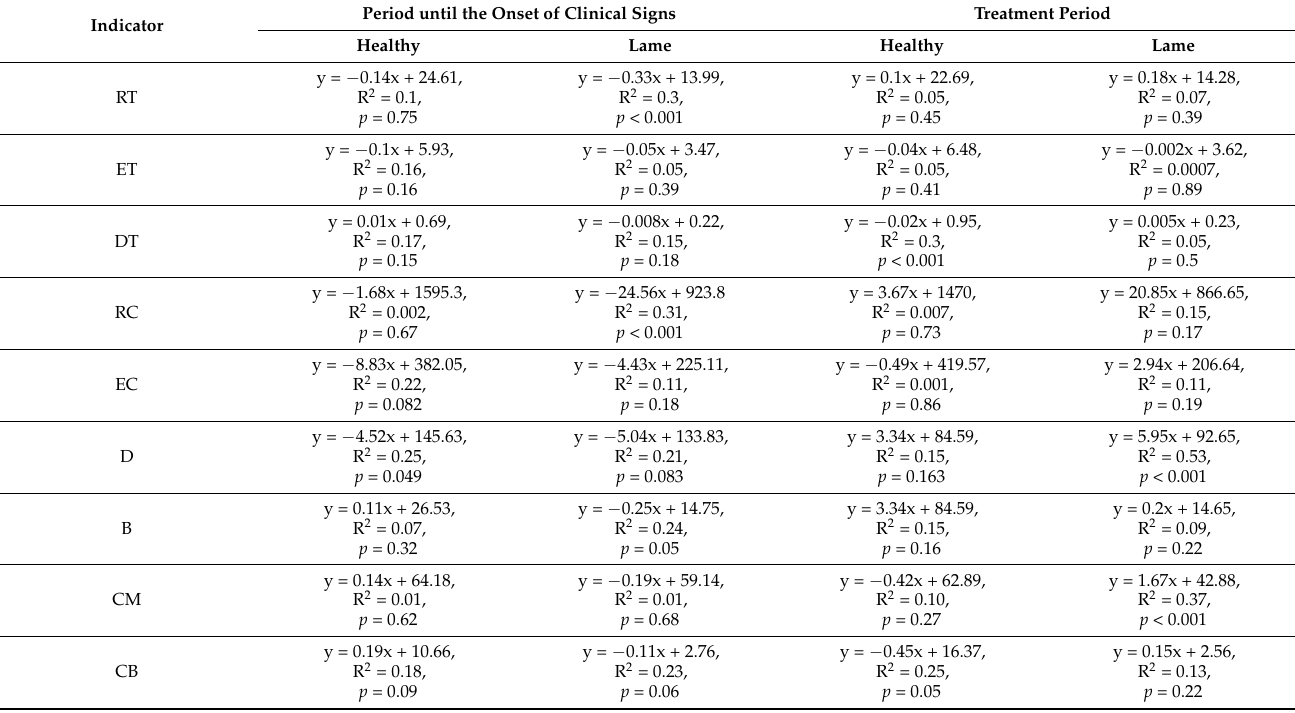
Table 4. Evaluation of changes in ingestive-related behaviors Indicators by period of the experiment.